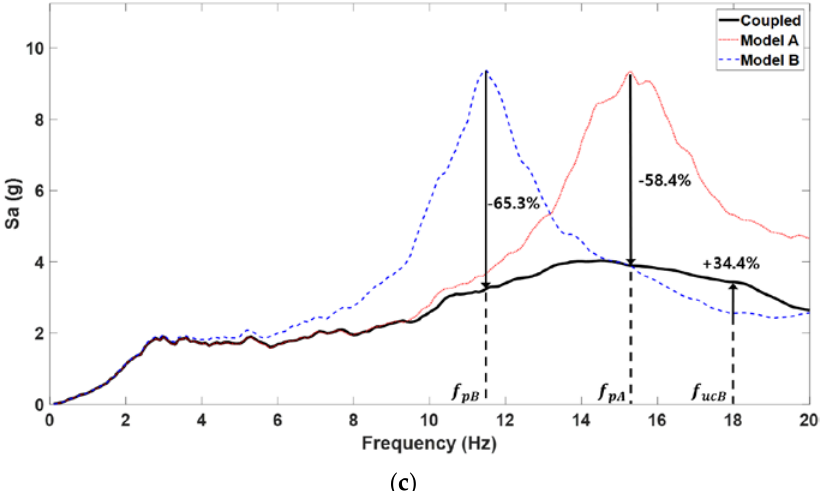
Figure 20. Application of Decoupled Analysis Criteria in ISRS (Model A): ( a ) Equipment Location 1; ( b ) Equipment Location 2; ( c ) Equipment Location 3.